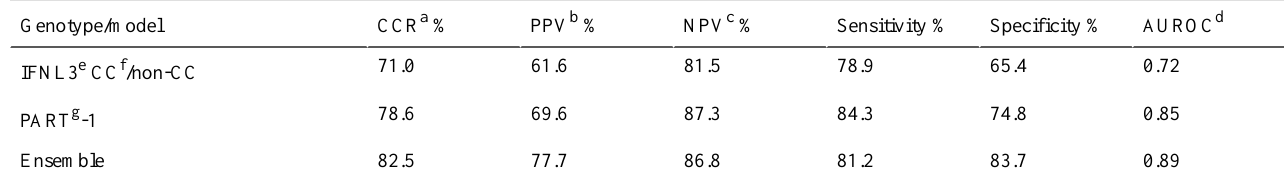
Table 2. Classification accuracy of IFNL3 (previous study) and models obtained (this study). Comparison made from the analysis of 138 patients without missing values for IFNL3.